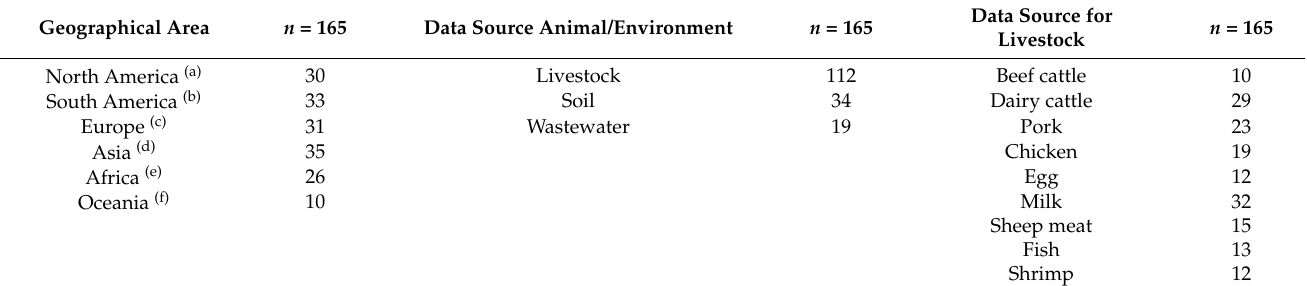
Table 2. Characteristics of the reviewed studies describing the number of articles found by continent and country to which they belong.